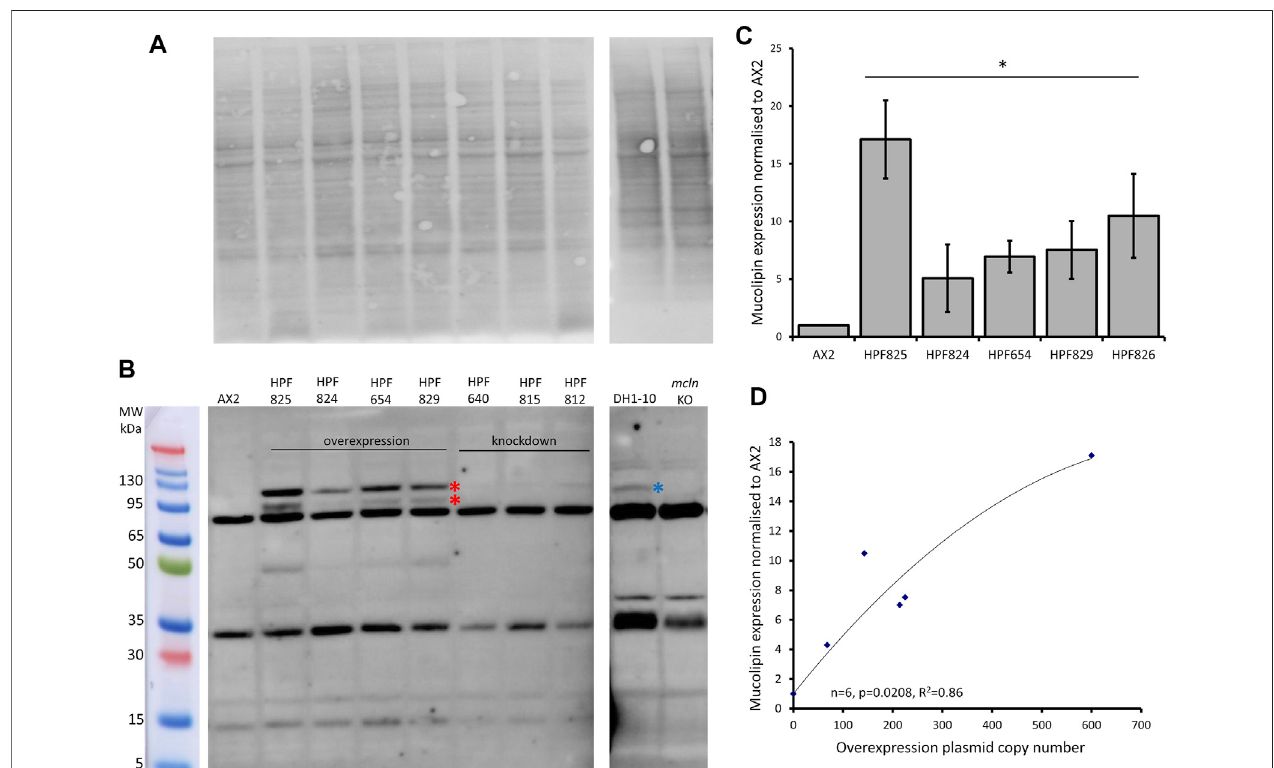
FIGURE 3 | Mucolipin can be detected in protein extracted from overexpression strains. (A) Total protein extracted from AX2, four representative mucolipin overexpression strains, three representative mucolipin knockdown strains, DH1-10 and mucolipin knockout, were separated by on a Bis-Tris-Plus gel by electrophoresis, transferred to PVDF membrane and stained with No Stain Protein Labelling Reagent (Invitrogen). Protein lysate for DH1-10 and mcln KO were kindly provided byProfessorPierre Cosson(Limaet al.,2012). (B) Western blotofthesame membrane, theanti-MUECDantibody detects multiplebands. Markers were the Broad Multi Color Pre-Stained Protein Standard (Genscript). Two bands of ~95 and ~120 kDa were absent in the mucolipin knockout cells but present in the mucolipin overexpression strains (Red stars) and the higher MW band also detected in DH1-10 (blue star). (C) Quanti fi cation of mucolipin expression in overexpression strains. To quantify mucolipin expression the combined intensity ofthe 120and 95 kDa bands wasmeasured in Image Lab ™ and normalised tothe intensity of the total protein loaded in each lane (A) . Expression in each strain was then and normalised to AX2 expression. As no bands were visualised for AX2 at these sizes, AX2 expression was determined by measuring the intensity of a similar sized area on the blot where the bands would be located. Each strain was tested 2 – 4 times and data waspooledfromeachexperimentandthemeanscalculated(errorbarsarestandarderrorsofthemean).ExpressionisrelativetoAX2andisincreasedinoverexpression strains(*= < 0.05,One-WayANOVA,withpairwisecomparisonsmadebytheLeastSquaresDifferencemethod,AX2vs.strain). (D) Proteinexpressioninoverexpression strainscorrelates with overexpression construct copy number.AX2 had aconstruct copy number of0asdoes notcontainan overexpressionconstruct. Thecorrelation was highly signi fi cant (Spearman ’ s rank p = 0.0208 and Kendall ’ s rank p = 0.0194).